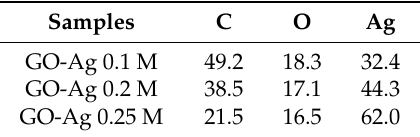
Table 2. The energy dispersive X-ray spectroscopy (EDX) elemental composition (at %) for Ag NPs attached on the GO sheet